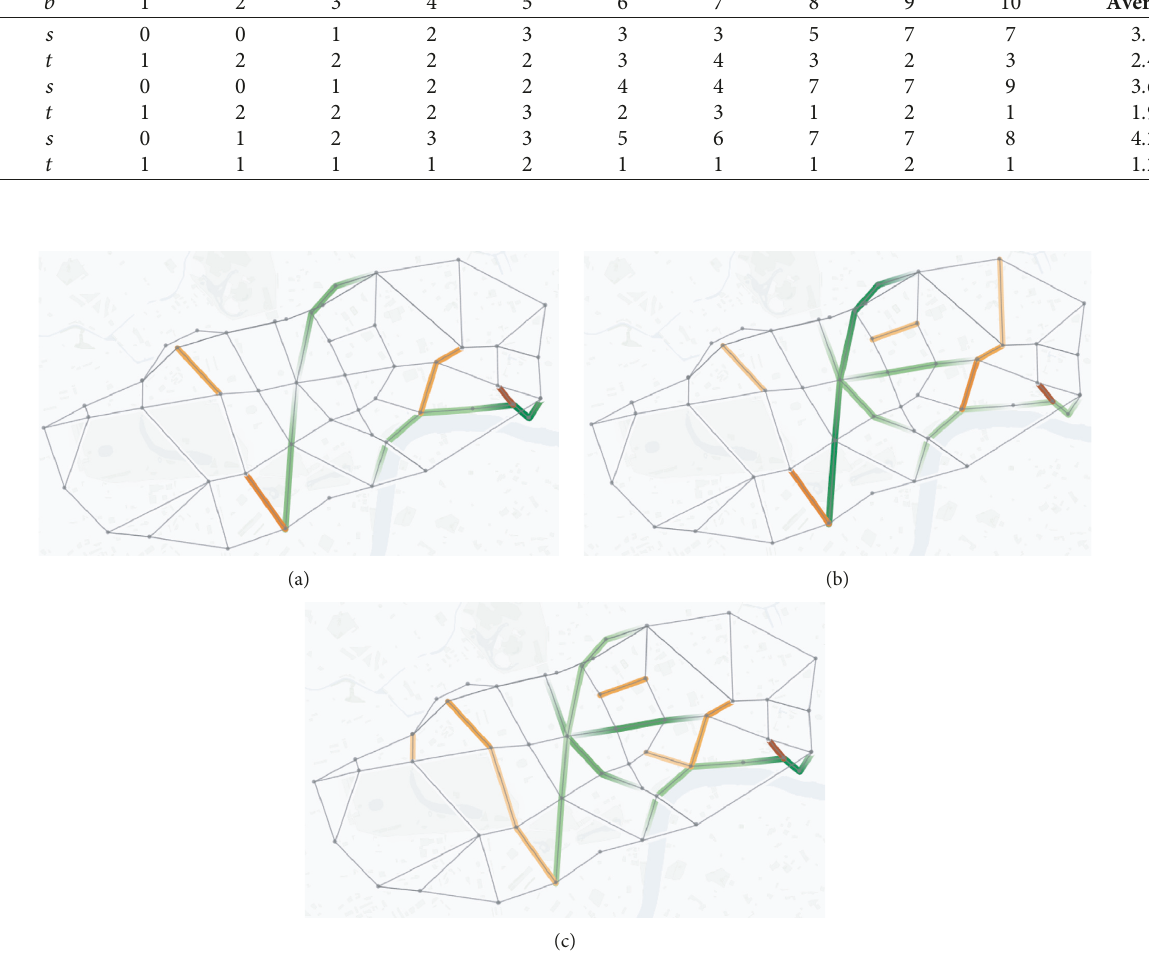
Figure 10: Links most frequently selected in expansion and fortification plans. (a) u � 1. (b) u � 2. (c) u �